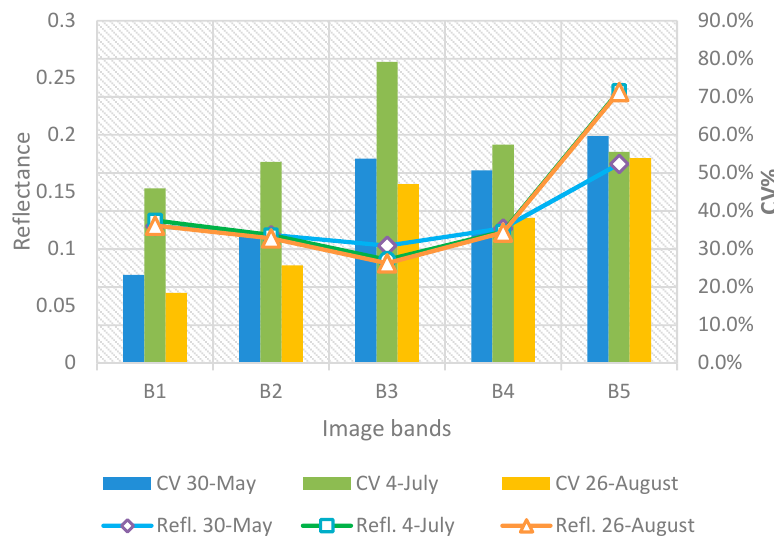
Figure 4. Spectral signatures and spectral variation (CV%) detected in the RapidEye images per band and date within the rice fields of the farm.